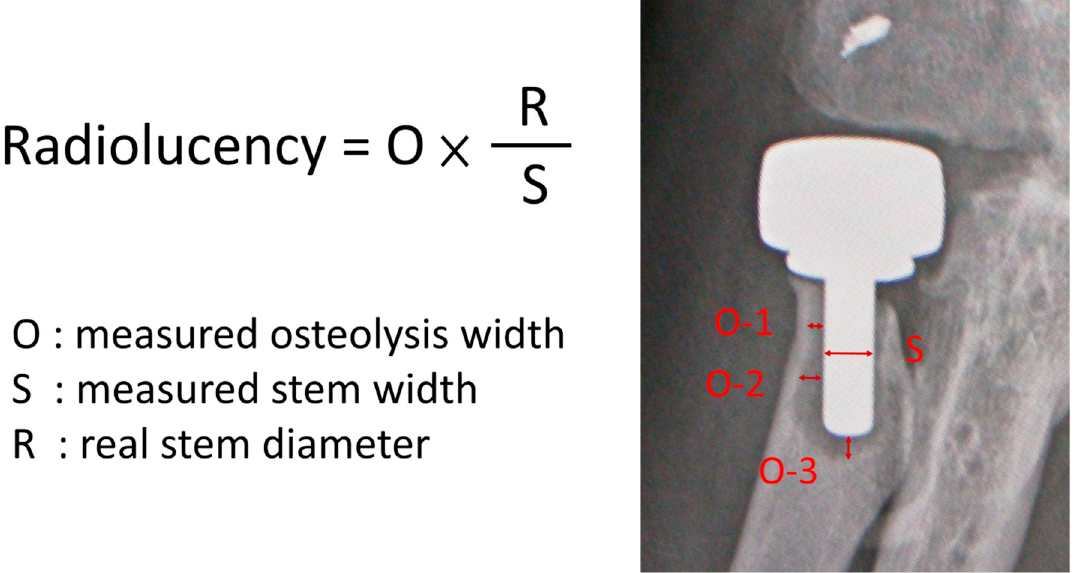
Figure 3. The measured osteolysis width (O) in each of the 10 zones is calibrated with the ratio of the measured stem width on radiograph to the real stem diameter to obtain a real radiolucency thickness.